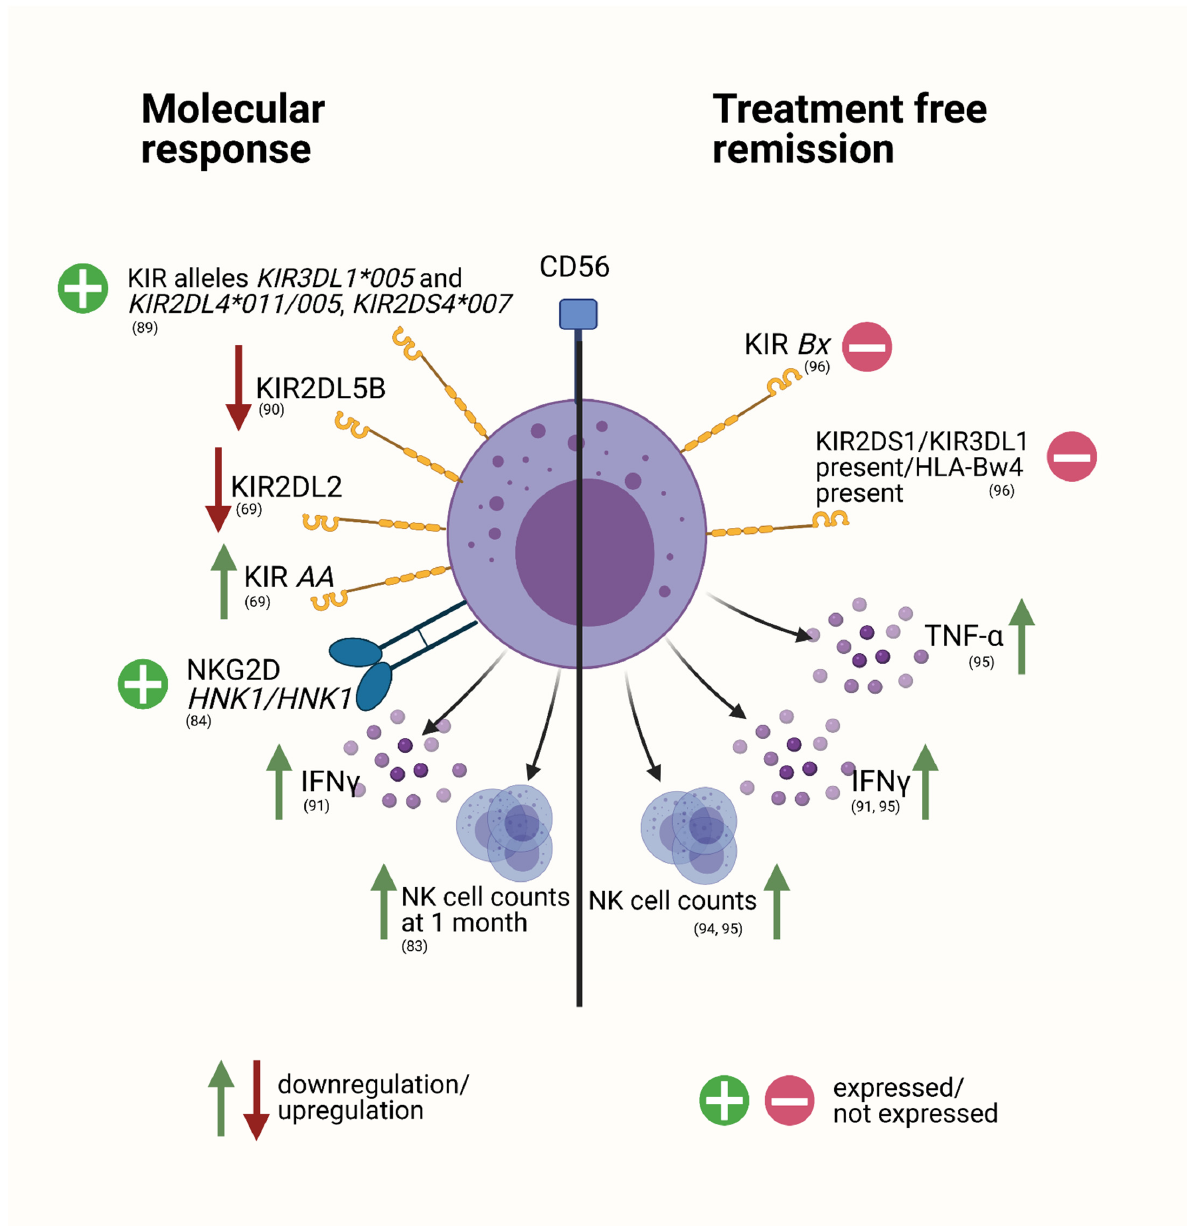
Figure 2. NK-cell associated changes serving as prognostic factors for molecular response or treatment free remission in CML. Green arrows indicate a favorable effect of an increase in the respective marker, while red arrows demonstrate that a decrease is beneficial to achieving molecular remission or treatment free remission. A circled green cross or red minus indicate a positive prognostic value of either the expression or absence respectively, of a certain marker. References are shown in brackets. Created with BioRender.com (accessed on August 27 th 2021). * refers to the genetic mutation A comprehensive investigation by Ureshino et al. on the predictive role of the inhib- itory receptor KIR3DL1 and the associated HLA-B allelic polymorphisms has revealed that weakly interacting combinations of these two counterparts were associated with a